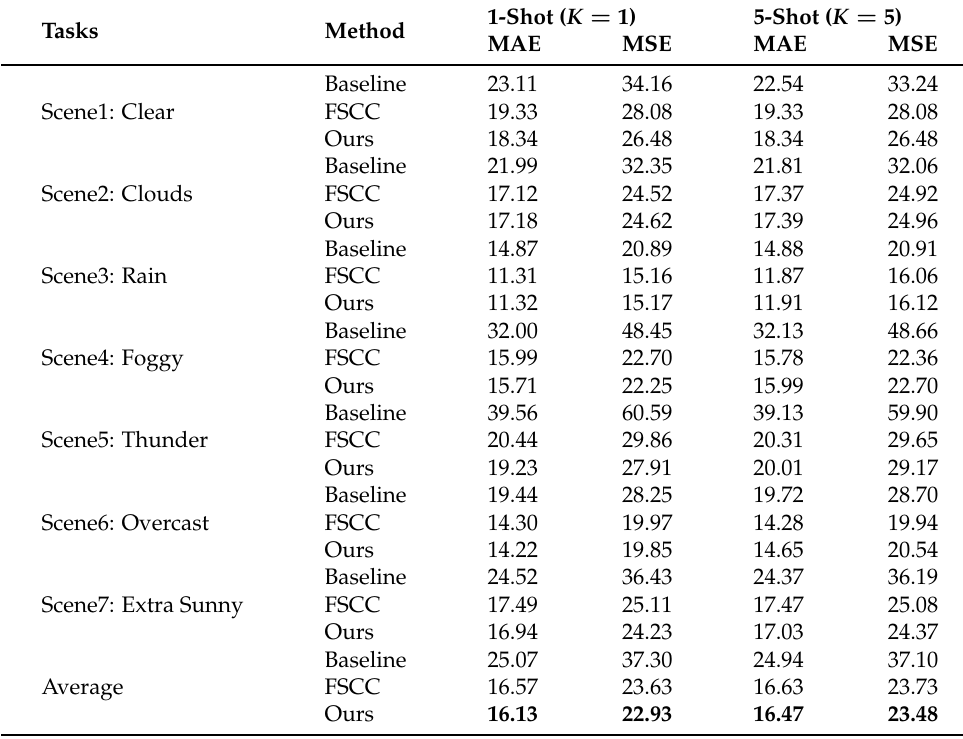
Figure 6. ( a ) shows the meta-learning rate β with initial value β 0 = 1 × 10 − 6 , ( b ) shows the meta-learning rate β with initial value β 0 = 1 × 10 − 3 . ( c ) shows the loss with different values of hyper-parameter δ hyper . Table 1. Verification of the proposed dynamic- β MAML algorithm with δ hyper = 1 × 10 − 4 on dataset GCC by comparing with baseline and FSCC [13]